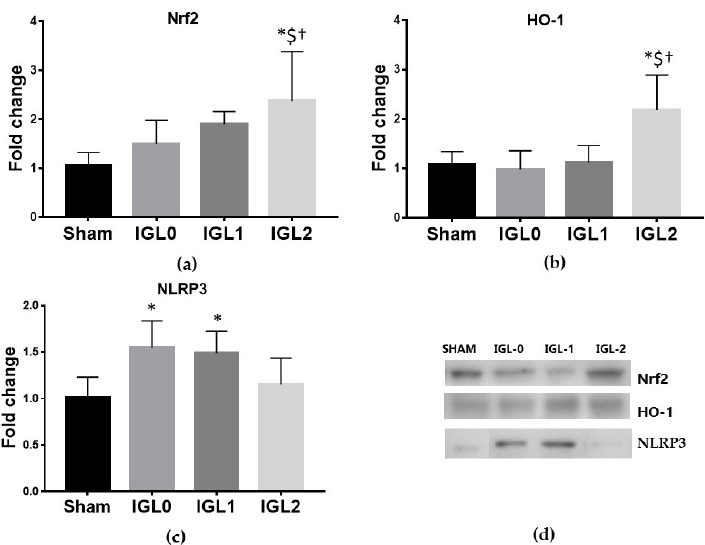
Figure 4. Nrf2-mediated response to oxidative stress in steatotic livers preserved (4 ◦ C, 24 h) in the IGL-0, IGL-1, and IGL-2 solutions vs. Sham: ( a ) Nrf2 transcription factor; ( b ) HO-1; ( c ) NLRP3; and ( d ) representative blots. The bars represent the mean values ± SD of each group ( n = 4–6). Nrf2 and HO-1 expression followed the same trend, being higher in the IGL-2 group compared to in the other groups. Differences are shown comparing groups (* vs. Sham, $ vs. IGL-0, and † vs. IGL-1) according to the one-way ANOVA test and the Tukey post-hoc test (one symbol indicates p < 0.05; two symbols indicate p < 0.01; three symbols indicate p <